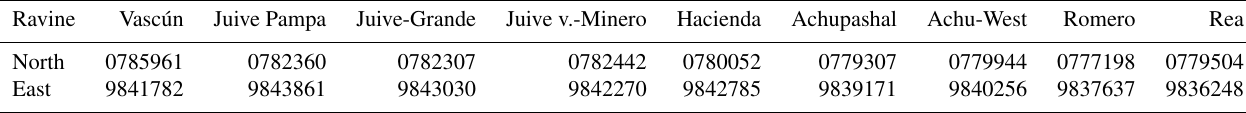
Table A1. Location of the most distal PDC front deposits.